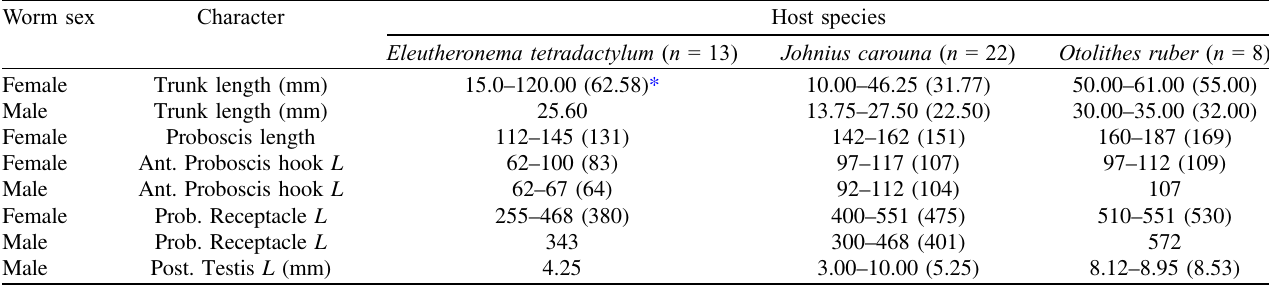
Table 3. The relationship between host species and size of certain anatomical structures of 43 measured specimens of Neoechinorhynchus johnii collected off the Paci fi c coast of Vietnam mostly in